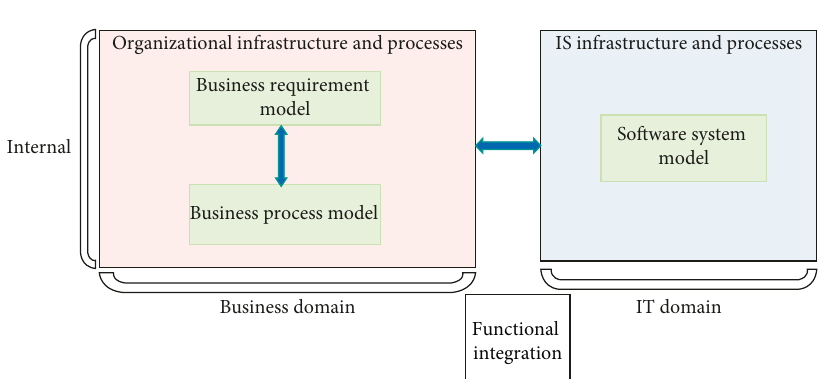
Figure 1: SAM according to